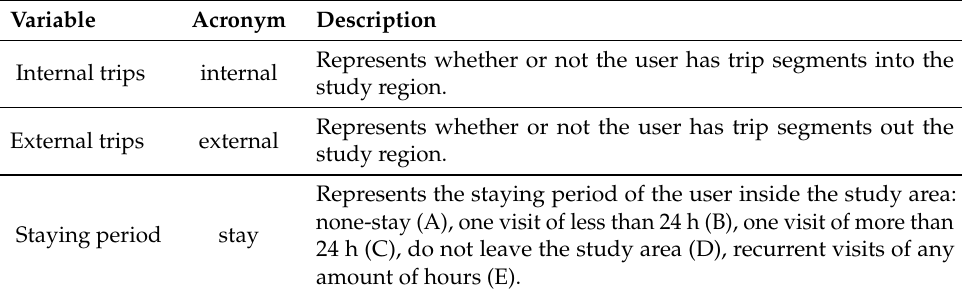
Table 2. Description of the variables for the clustering